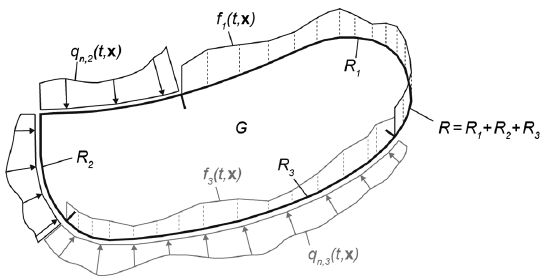
Fig. 2. Domain G and edge R of the heat conduction problem (Kaempf